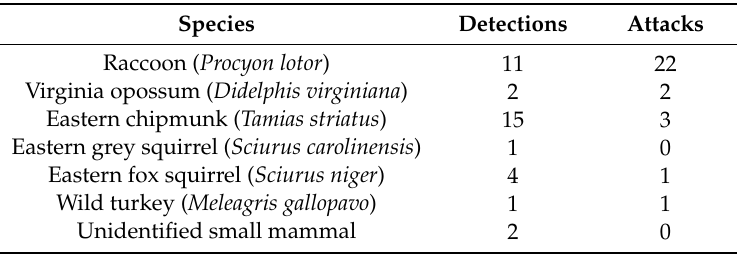
Table 1. Number of interactions (detection and attacks) with three-dimensional printed turtle models by each observed predator species.